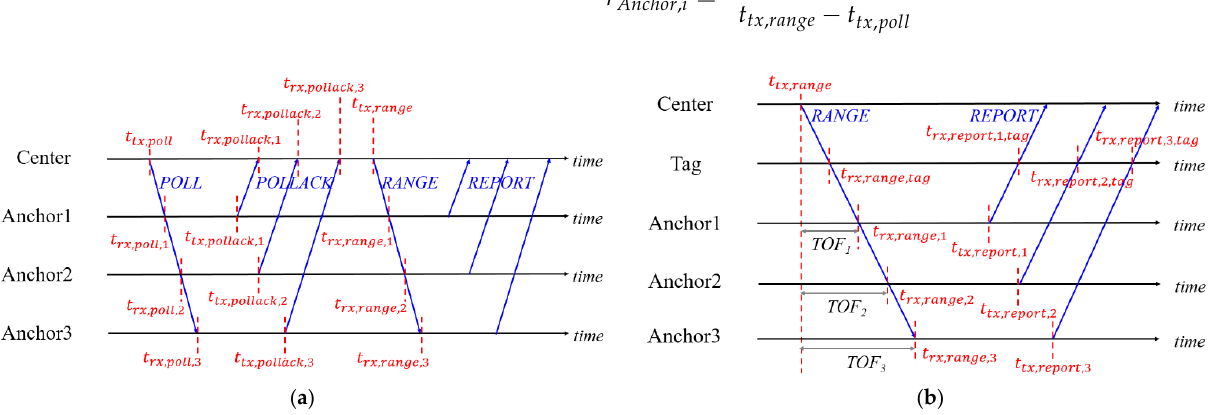
Figure 3. ( a ) The modified TWR between the Center and anchors. ( b ) TDOA with anchor synchronization.